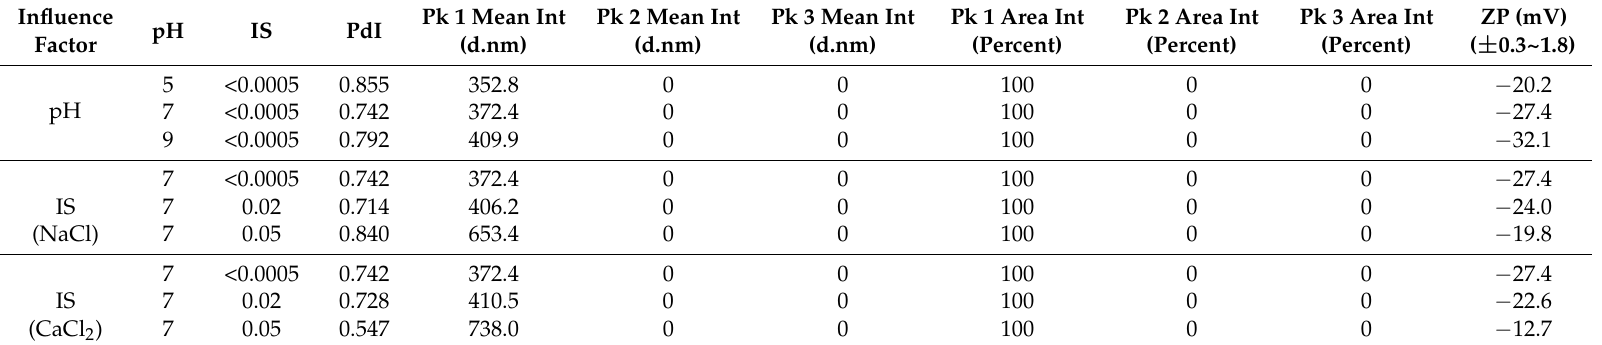
Table 1. Physical and chemical properties of silica colloid under different